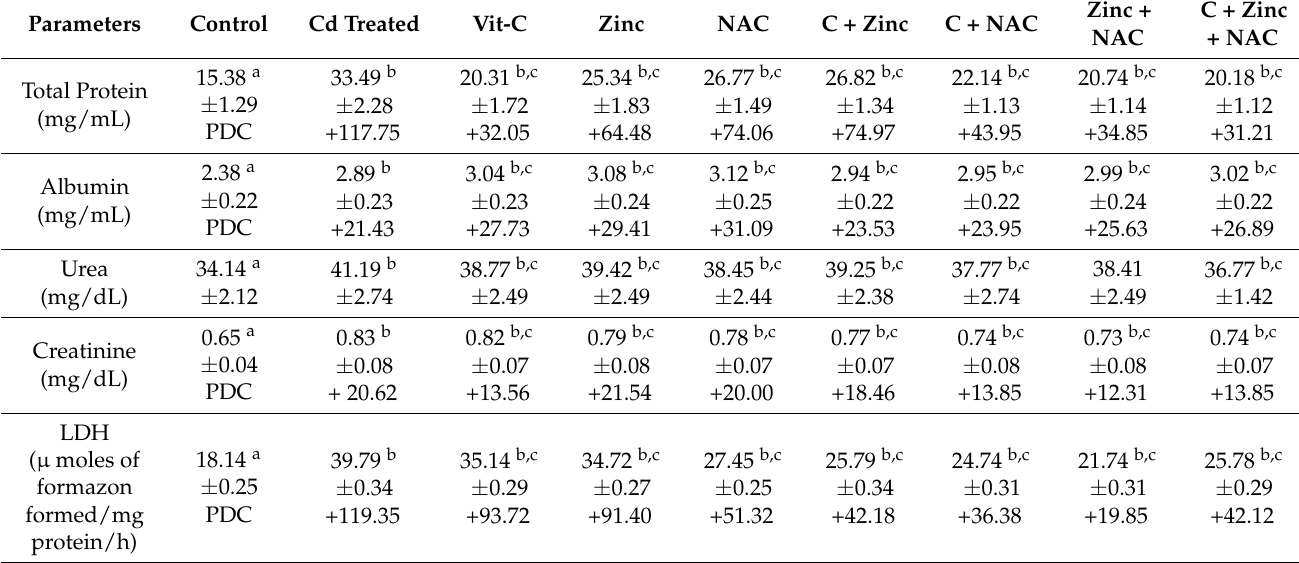
Table 3. Biochemical Parameters in Tissues/Serum of Rats under different Experimental